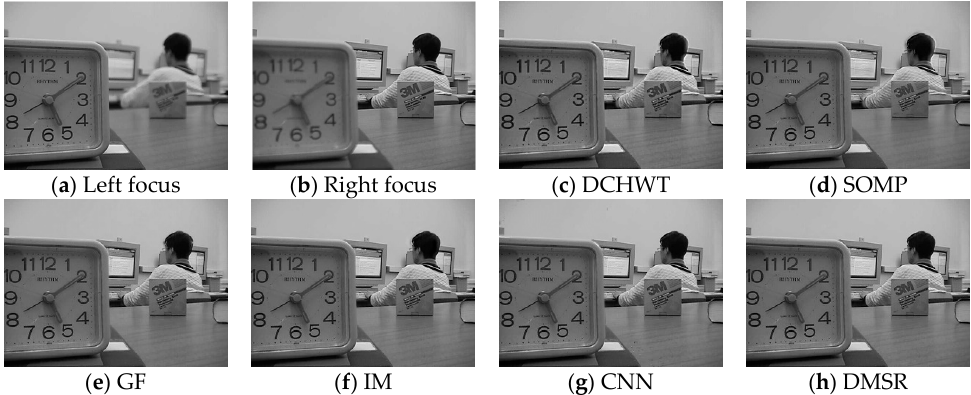
Figure 8. The “Lab” source images and fusion results obtained by different fusion methods.